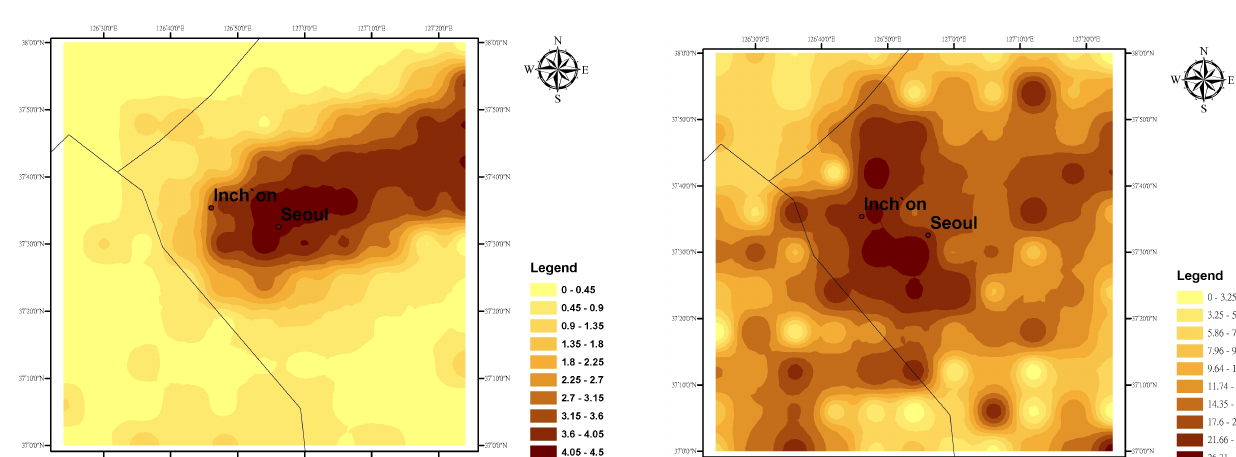
Fig. 3. Spatial distribution of positive flash density (flkm − 2 yr − 1 ) over Seoul for the years 1989–1999.